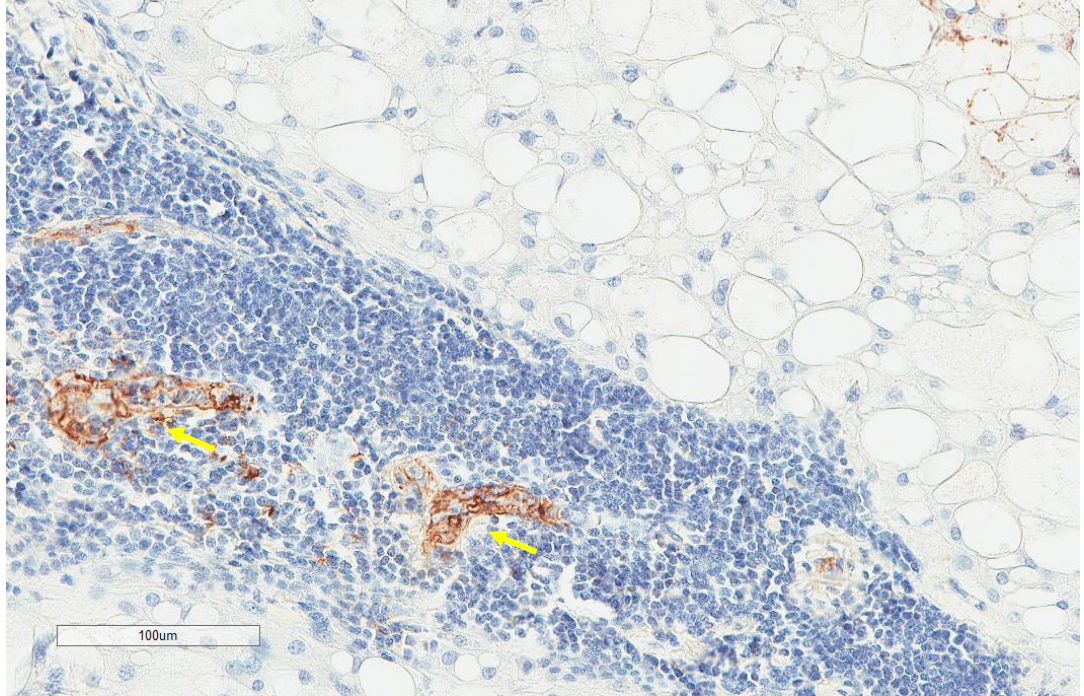
Figure 15. Representative images (same tumor focus as previous image at ×200 magnification) with the corresponding MECA-79+ high endothelial venules (yellow arrows).